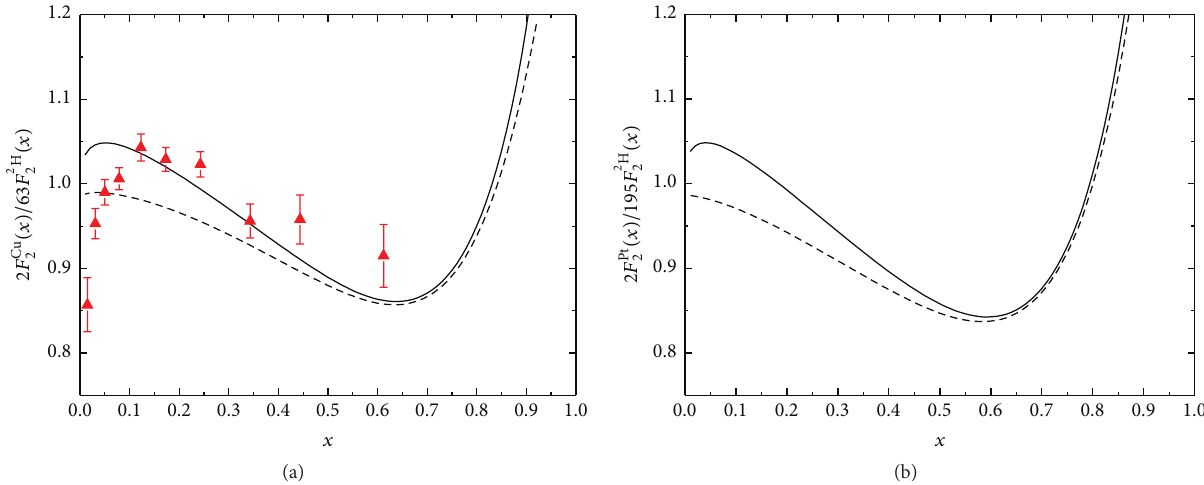
Figure 6: (a) and (b) show the ratio 𝑅 = 2𝐹 𝐴 2 /𝐴𝐹 2 𝐻 2 in terms of 𝑥 for Cu and Pt nuclei. The full curve shows the results by considering the Fermi motion, the binding energy, and the pionic contribution effect. The dashed line shows the results by considering the Fermi motion and the binding energy. Experimental data are taken from [19].